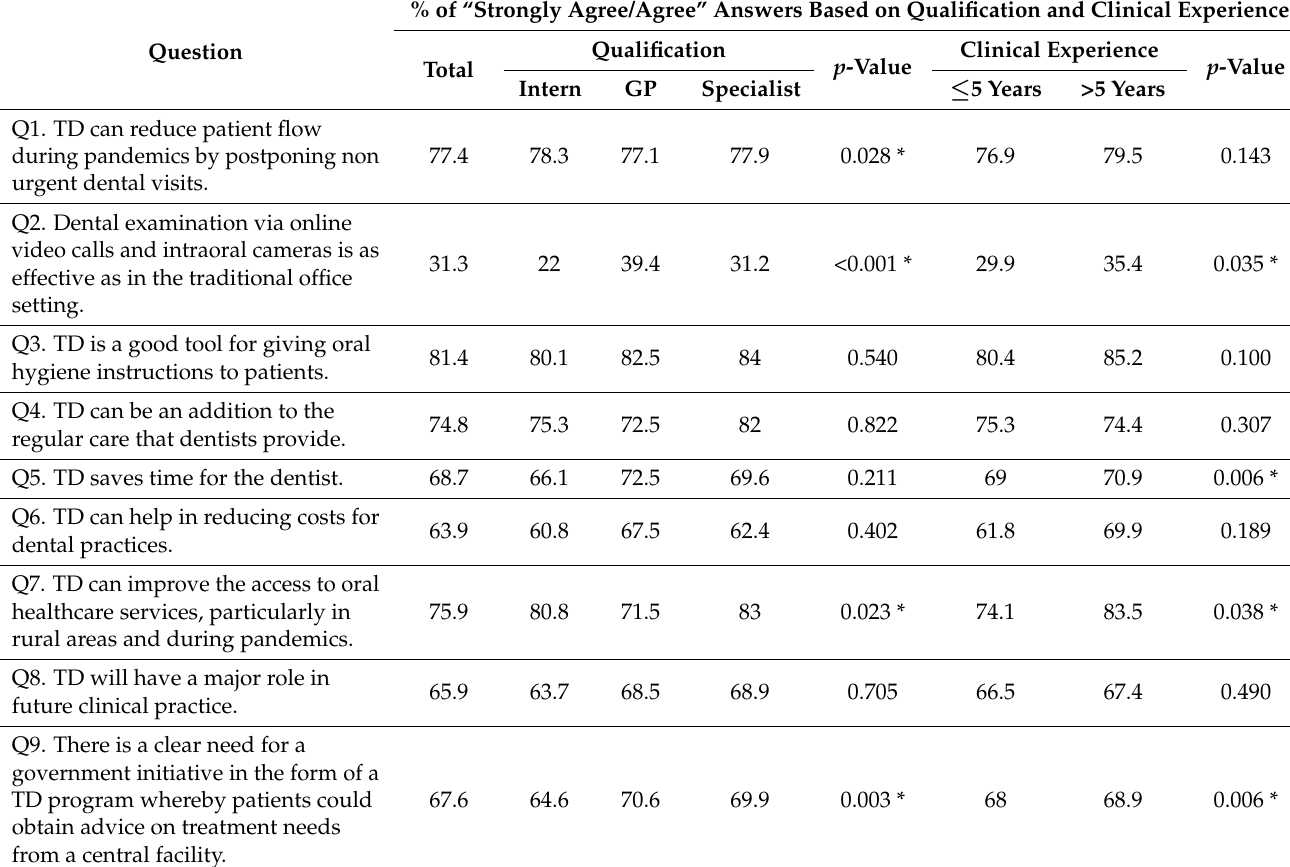
Table 3. Responses of participants to attitude-related questions based on qualification and clinical experience ( n = 603).